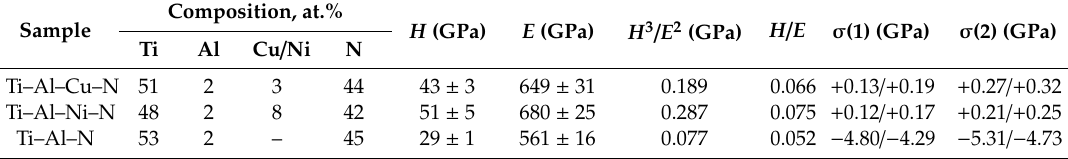
Figure 5. Cu2p ( a ) and Ni2p ( b ) X-ray photoelectron spectra of the Ti–Al–Cu–N and Ti–Al–Ni–N coatings.